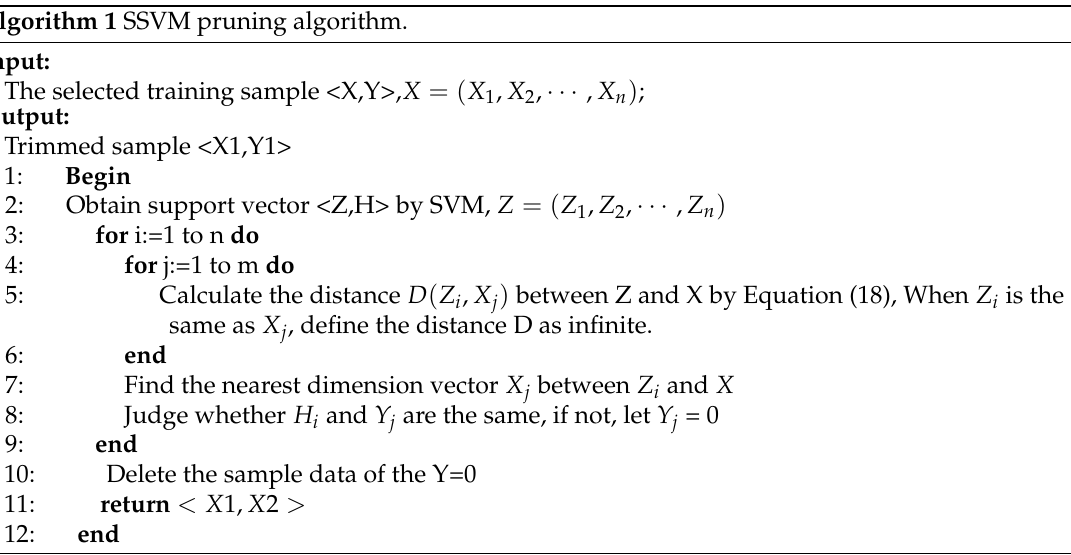
Algorithm 1 SSVM pruning algorithm.